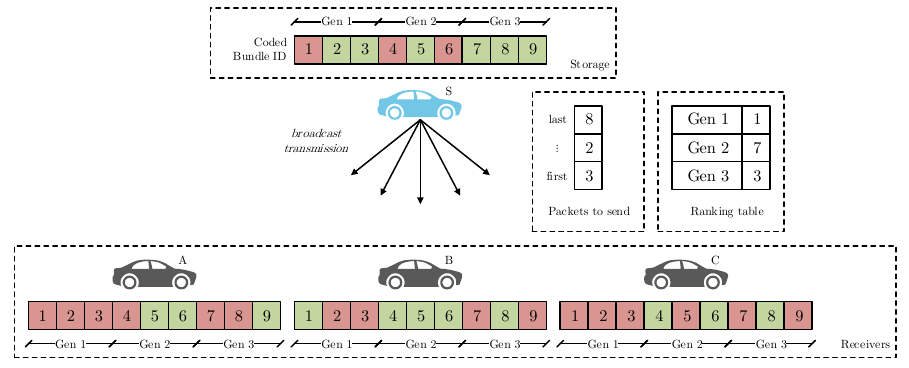
Figure 6. Forwarding decision of LRGF strategy—2nd